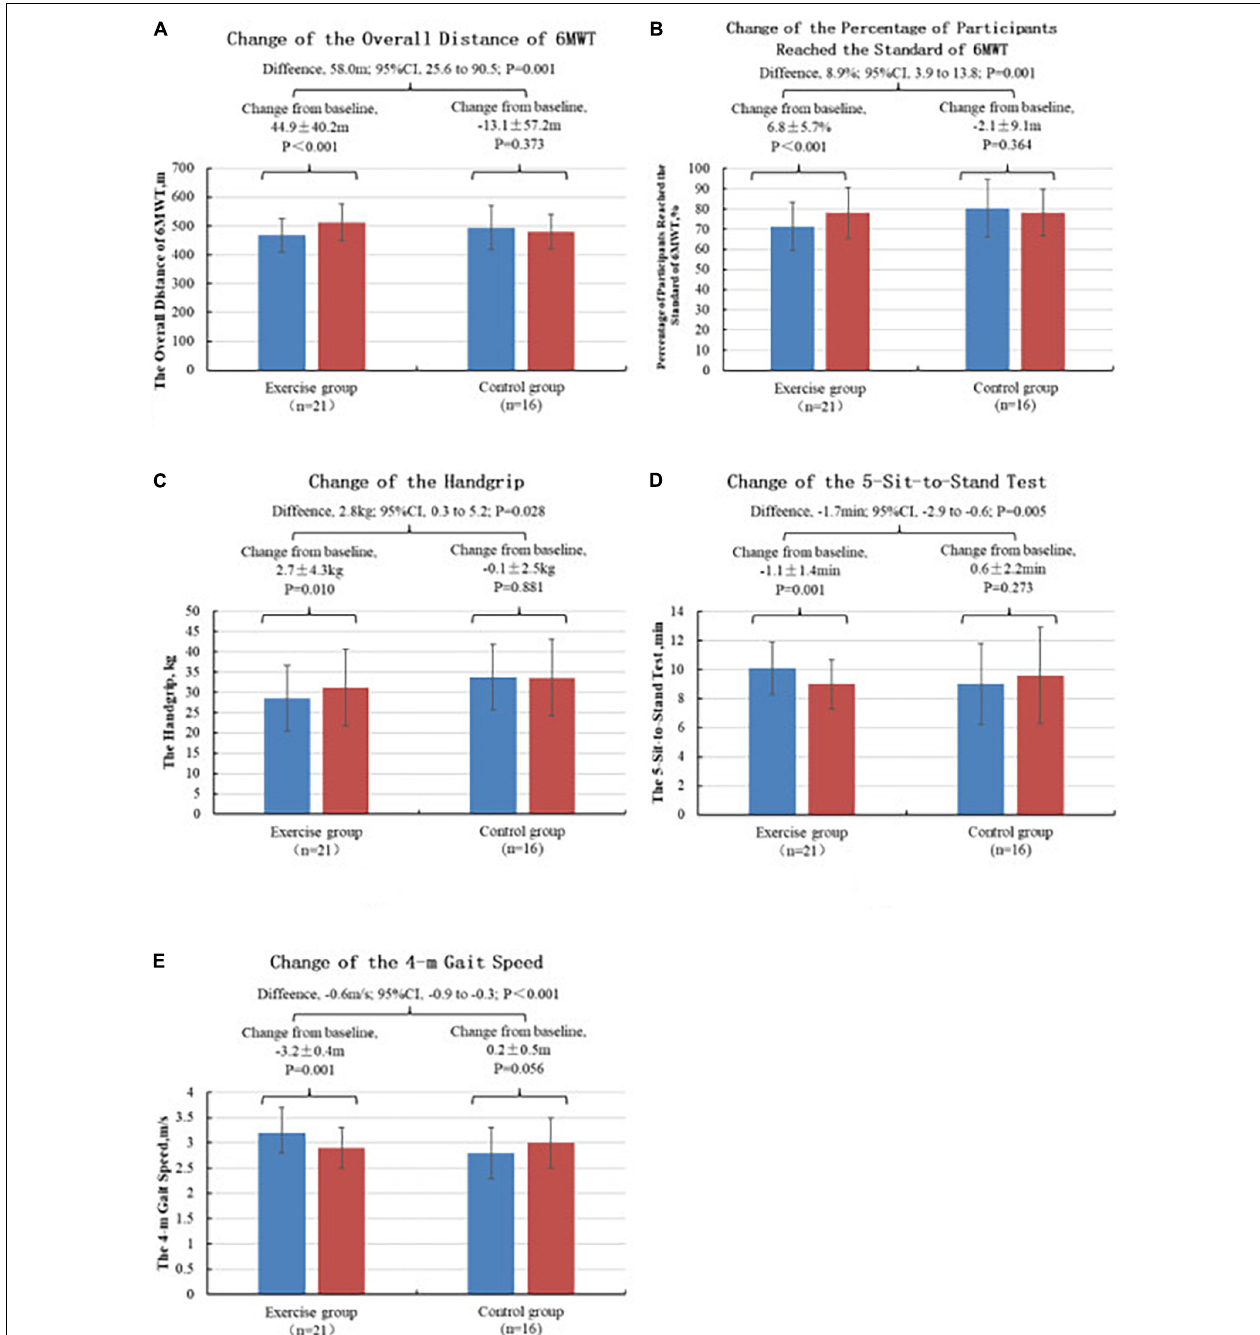
FIGURE 2 | Changes in primary outcomes. (A) Comparison of the measured distance change values of 6MWT between two groups of subjects, *** P < 0.001. (B) Comparative analysis of the values of the percentage change in the measured distance attained for 6MWT in two groups of subjects, *** P < 0.001. (C) Comparative analysis of grip strength change values between the two groups of subjects, * P < 0.05. (D) Comparative analysis of the change values of the 5R-STS for the two groups of subjects, ** P < 0.01. (E) Comparative analysis of the change values of the 4-meter gait speed for the two groups of subjects, *** P < 0.001. * p < 0.05, ** p < 0.01, and *** p < 0.001.